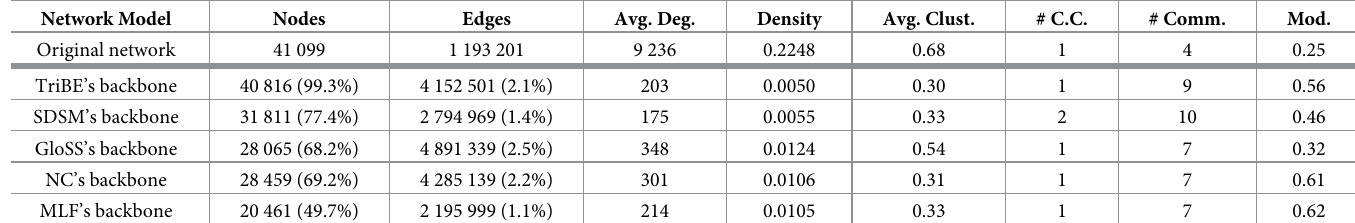
Table 2. Online discussions on Instagram: Topological metrics of the network and backbones extracted by each candidate method. Columns 2-3 contain total num- bers for the original network and also the corresponding percentages for backbones. Network Model Nodes Edges Avg. Deg. Mod. Original network SDSM’s